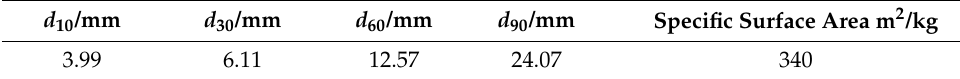
Figure 4. Particle size distribution of MS used in the experiment. Table 2. Particle size characteristic parameters of MS.